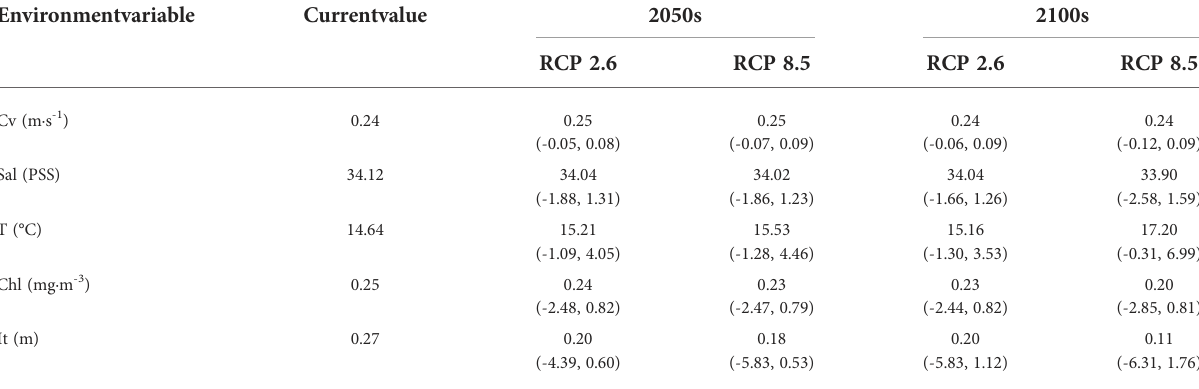
TABLE 3 Current and future (i.e., 2050s and 2100s) environmental conditions under two representative concentration pathway (RCP) emission